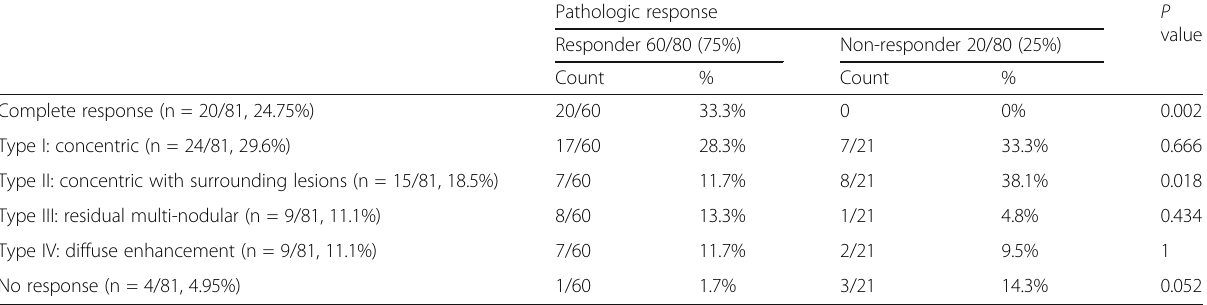
Table 5 Correlation between shrinkage pattern and pathologic response